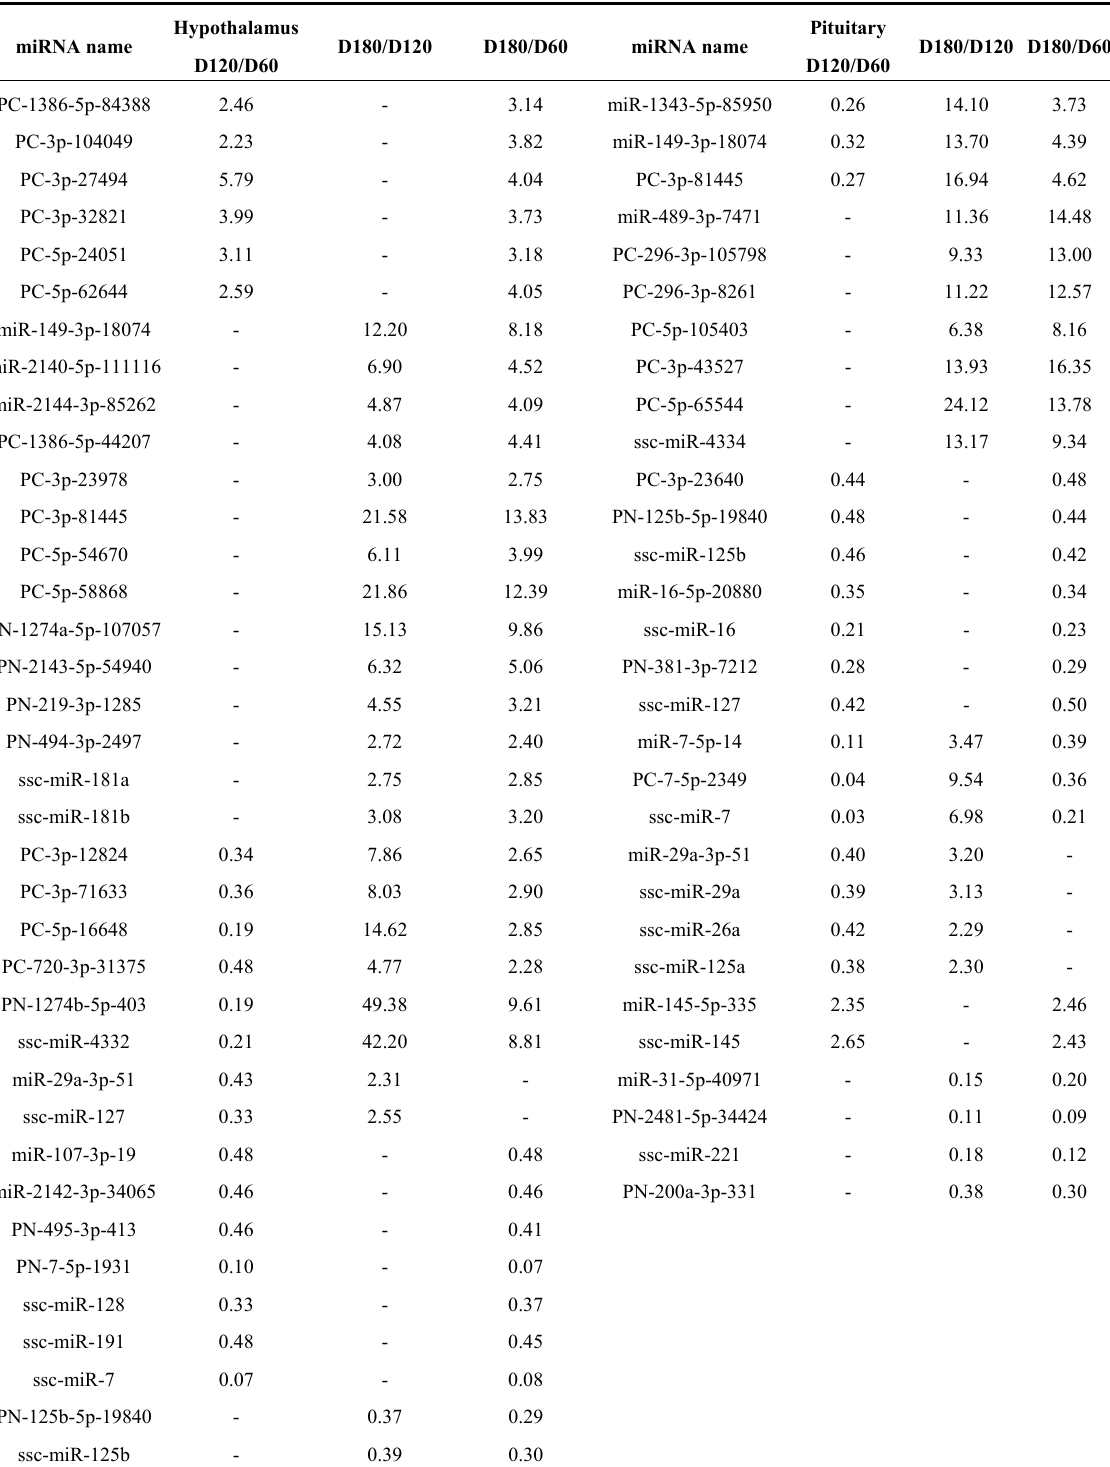
Table 1. miRNAs differentially expressed among D60, D120, and D180 (Fold change >2, q < 0.001, and FDR <